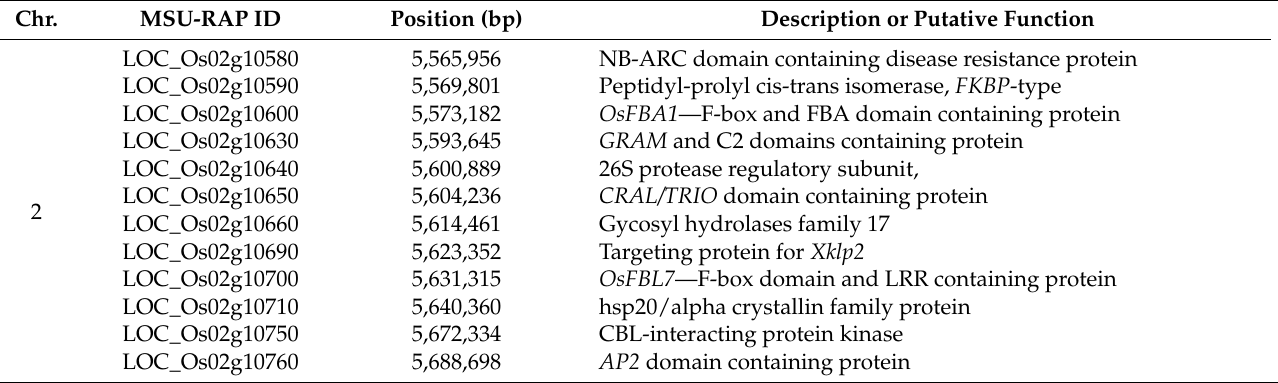
Table 2. Putative candidate genes annotated in ~200 Kb genomic regions in identified novel MTAs qSDW2.1 and qSNC5.